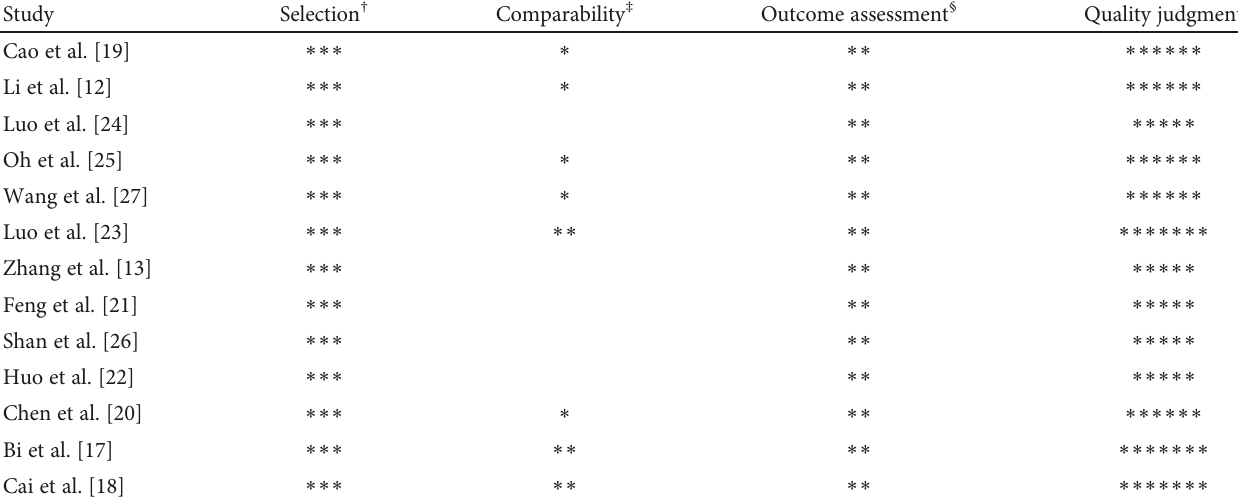
Table 2: Quality assessment of studies pooled in the meta-analysis based on the modi fi ed Newcastle-Ottawa Scale judgment. Study Selection